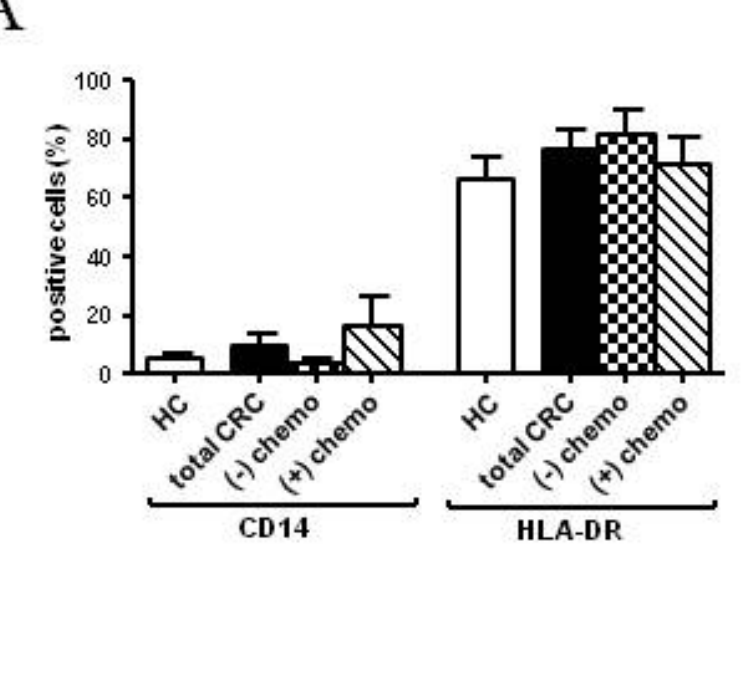
Figure 3. Phenotypic and functional characteristics of MoDs. A comparison of the total, chemotherapy-treated and untreated CRC patients and healthy controls at the third timepoint: a. Evaluations were performed at the ( A ) sixth and ( B ) seventh days of culture (after LPS addiction). CRC patients, n = 11; untreated patients, n = 6; chemotherapy-treated patients, n = 5; HCs, n = 14. Data are shown as the means ± SEM. * p < 0.05; ** p < 0.01. Statistical significance is in comparison to HCs, except where indicated. MoDCs: monocyte-derived dendritic cells; LPS: lipopolysaccharide; HC: healthy controls; CRC: colorectal cancer; MLR: mixed lymphocyte reaction; MFI: mean fluorescence intensity; the n indicates the number of cases